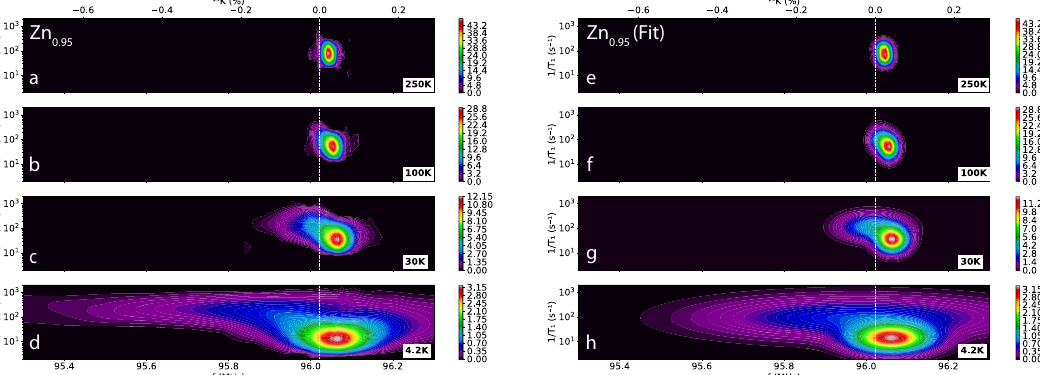
Fig. 7 Evolution of C ( f ; 1/ T 1 ) for Zn 0.95 . a – d Representative C ( f ; 1/ T 1 ) results at various temperatures observed for Zn 0.95 . The vertical dashed line marks the zero Knight shift frequency 19 f 0 . See Supplementary Materials for the complete set of data as well as the animation (movie) of the temperature evolution of C ( f ; 1/ T 1 ). e – h C ( f ; 1/ T 1 ) at corresponding temperatures, deduced from the summation of the two Gaussian functions in the two-dimensional f and 1/ T 1 space that best fi t the experimental results in a – d . Note that above 100 K, the two-dimensional gaussian does not capture the behavior of the side peak as it is merged into the main peak.